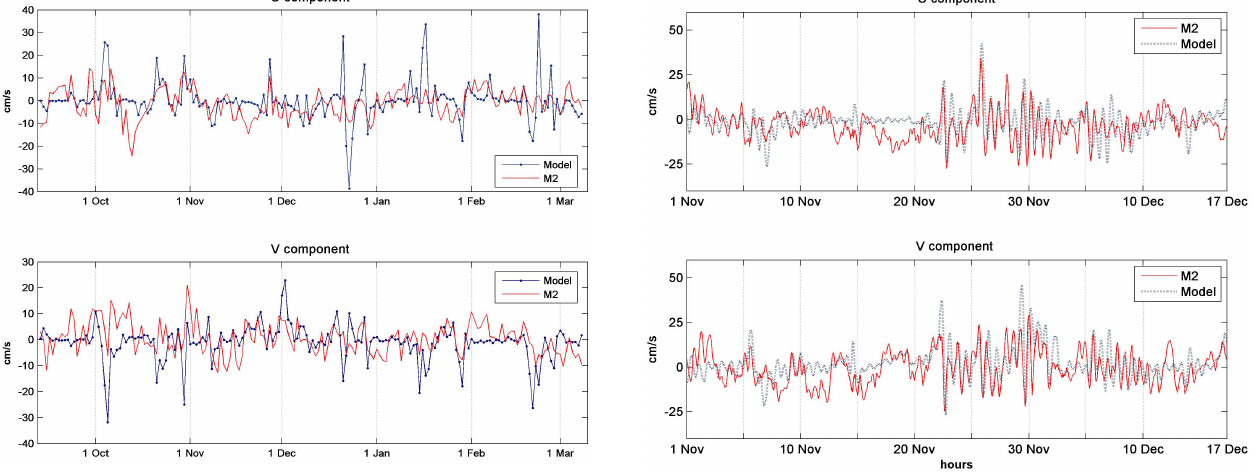
Fig. 17. Comparison of simulated and second mode surface cur- rents: hourly mean u and v component from 1st of November 2003 to 17th of December